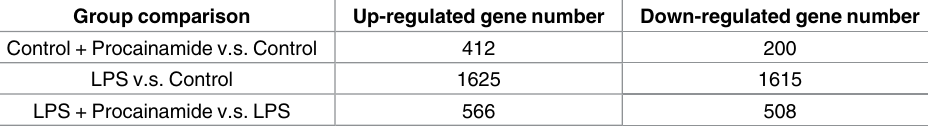
Depiction of the changes in gene expression in different groups of animals. Control, rats were given saline at time 0; Control + Procainamide, rats were given saline as in Control group and then given procainamide at 1 h; LPS, rats were given LPS at time 0; LPS + Procainamide, rats were given LPS at time 0 and then given procainamide at 1 h.